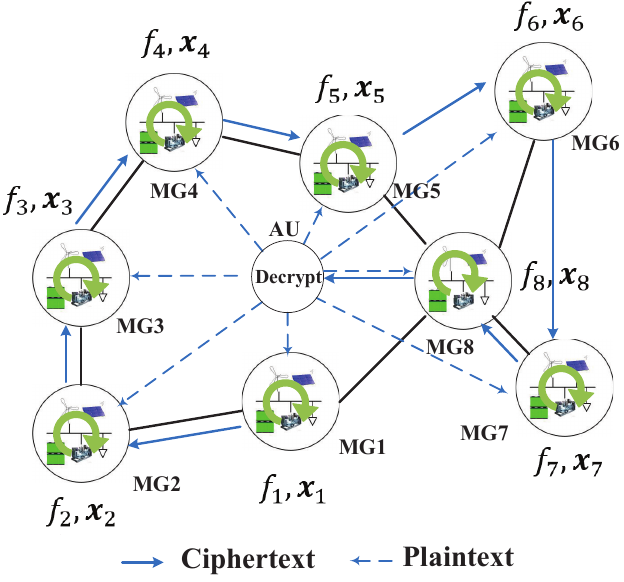
Figure 3. Information transmission process of the privacy-preserving